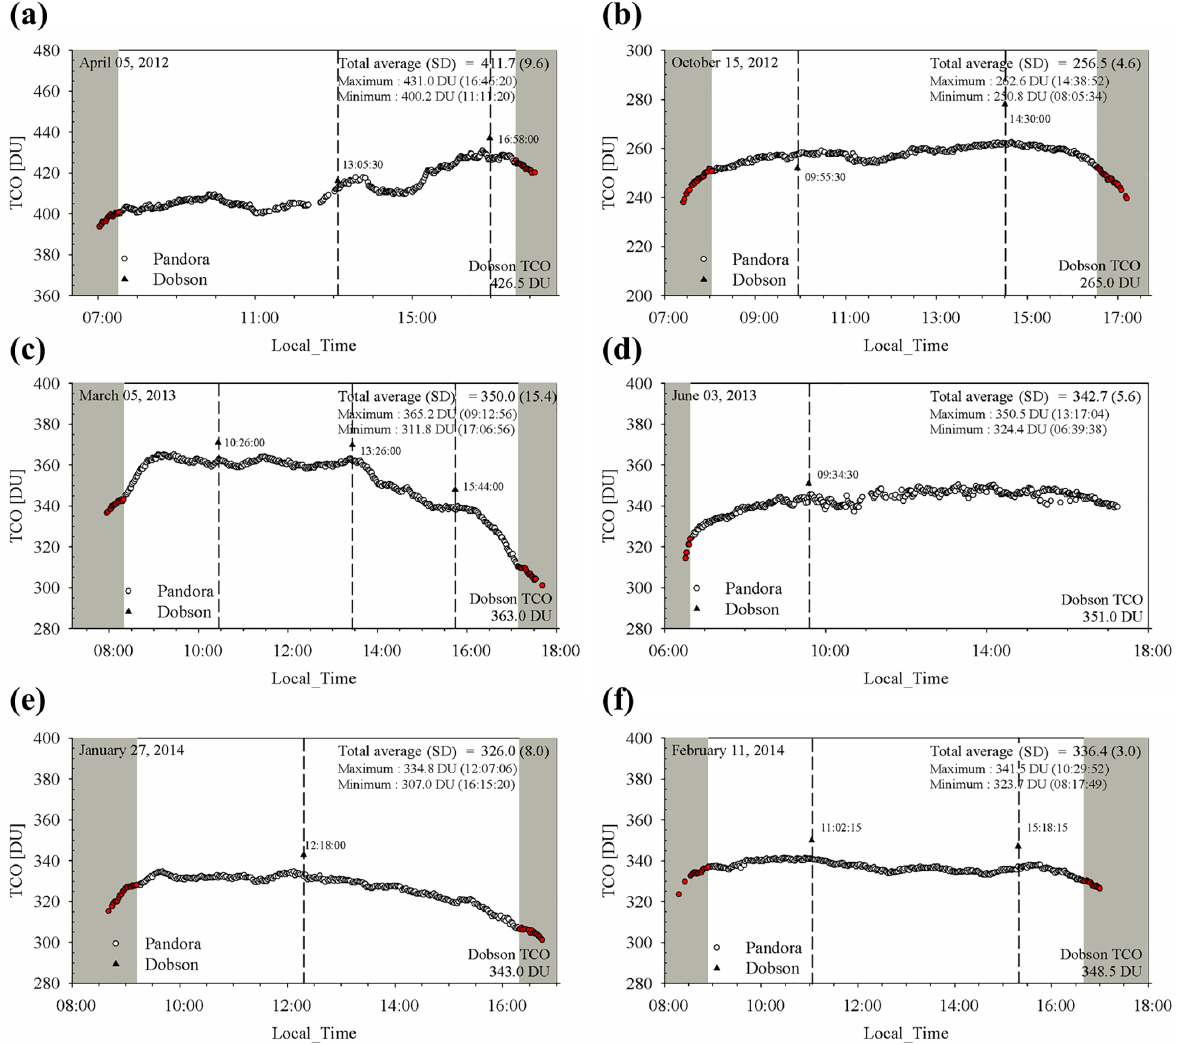
Figure 9. Diurnal variations in TCO values retrieved from Pandora for six randomly selected clear-sky days (cloud amount < 3) during the study period. TCO values measured at solar zenith angle > 75 ◦ are shaded and were removed from the calculations. Filled circles and dashed lines represent direct-sun TCO values measured by the Dobson instrument and observation times, respectively. All vertical axes have the same scale range of